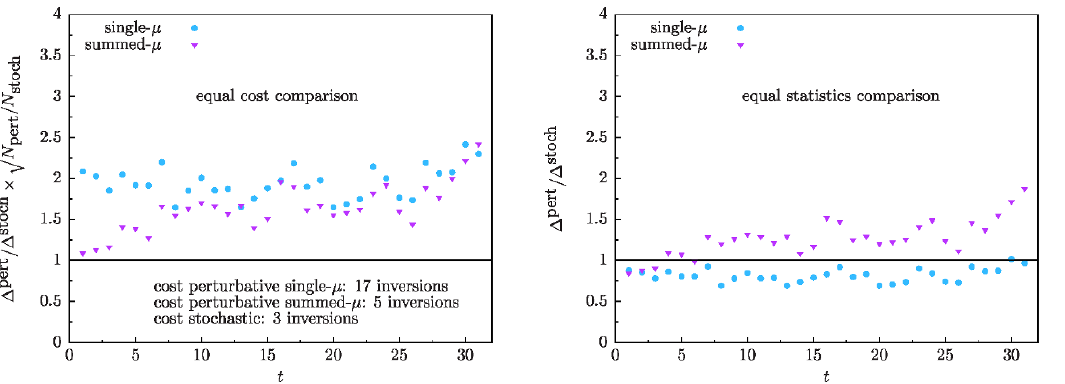
Figure 7 . Comparison of the statistical errors on the QED correction to the e(cid:11)ective mass of a charged kaon between the stochastic and the perturbative data. Blue circles and purple triangles are using the single- or summed- (cid:22) insertion technique for the perturbative method, respectively. The plot on the left is an equal cost comparison, the plot on the right an equal statistics